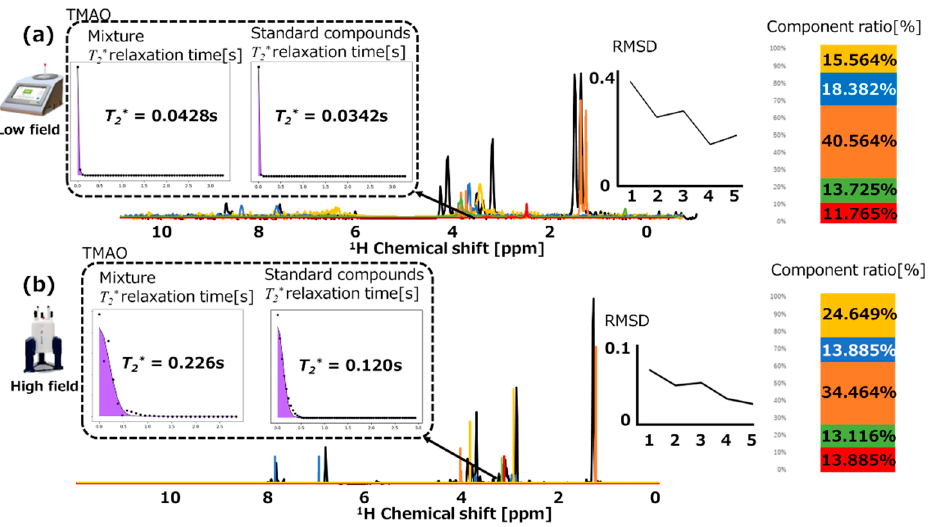
Figure 3. Assignment results and root-mean-square deviation values for standard compounds to food mixtures (tuna), which were measured through ( a ) low-field and ( b ) high-field NMR spectroscopy. The black curves represent the spectra of the food mixture. Red, green, orange, blue, and yellow represent the spectrum and component ratio of choline, trimethylamine N -oxide (TMAO), lactate, histidine, and creatine, respectively. Calculated representative T 2 * relaxation times are depicted for TMAO in the food mixture and its standard compound.